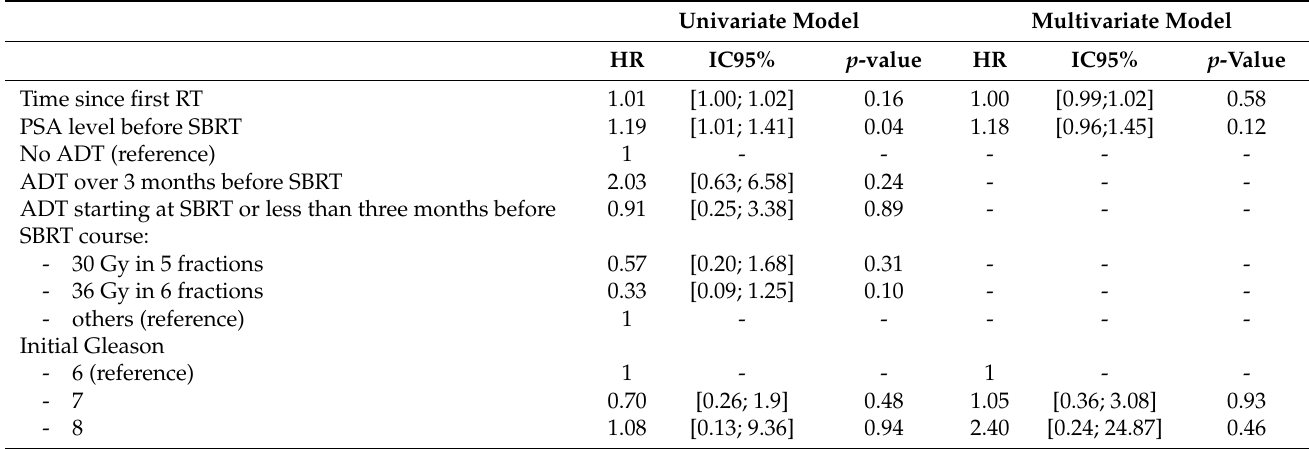
Figure 2. Biochemical free survival. Multivariable Cox regression analysis for BFRS failed to find statistically significant predictors of biochemical free survival (Table 5). In a univariable analysis, an increase in the PSA level before SBRT (HR = 1.19 (1.01; 1.41) p = 0.04) was slightly associated with a poorer BRFS. The difference between a high PSA before SBRT and a lower one (cut-off: 3 ng/mL) is illustrated by the Kaplan − Meier method in Figure 3. Table 5. Cox regression for biochemical free survival.